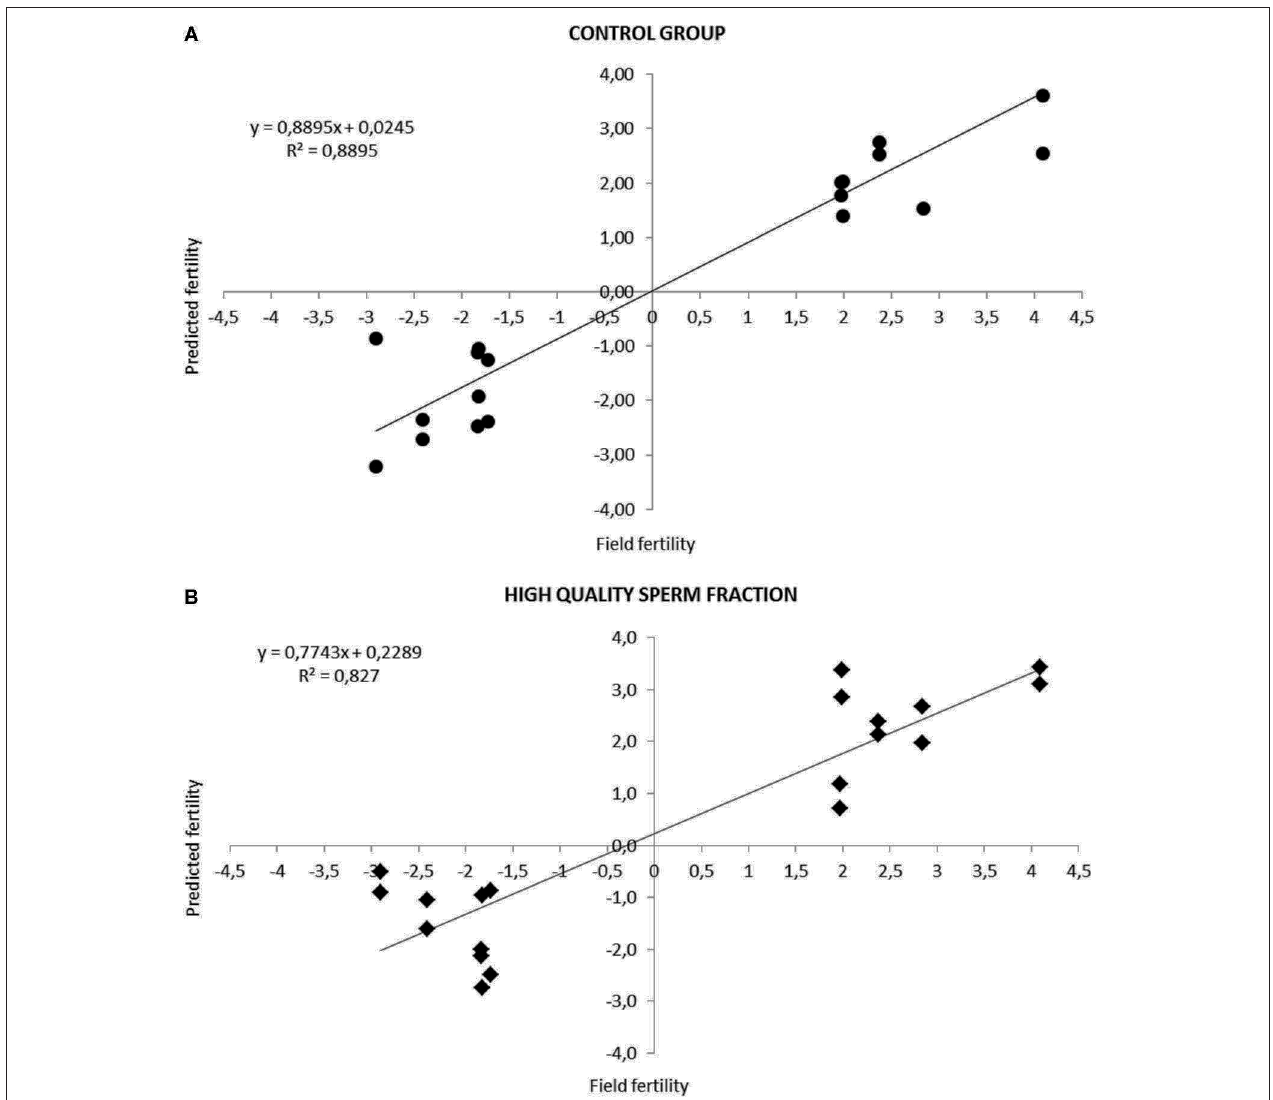
FIGURE 1 | Relationship between fertility rates predicted by the equation based on the combination of different sperm quality parameters and the observed field fertility in CG (A) and HQS fraction (B) . The line shows the trend in the